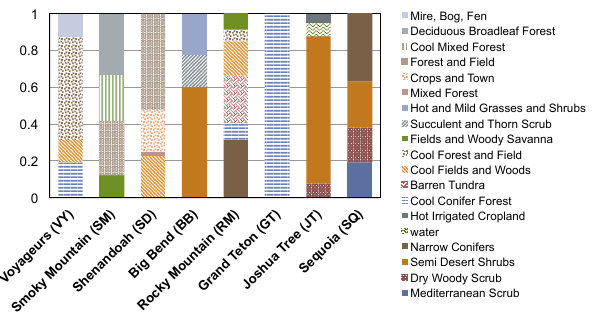
Figure 1. Composition of vegetation types of select Class I areas used in this study based on Olson (1992).